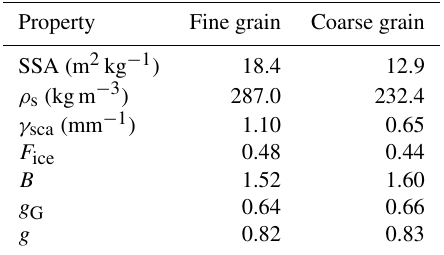
grain mesh samples. Note that SSA (snow specific surface area) and ρ s are computed directly from the µCT sample. The geometric ( g G ) and total asymmetry parameters ( g ) are computed as described in Fig. 2.